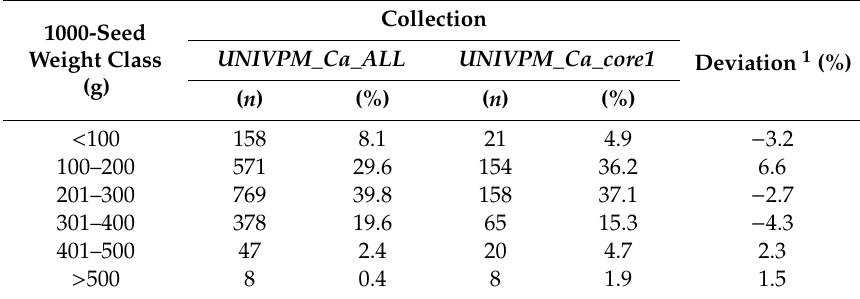
Table 4. Number of accessions and relative frequency of UNIVPM_Ca_ALL and UNIVPM_Ca_core1 for the 1000-seed weight classes.